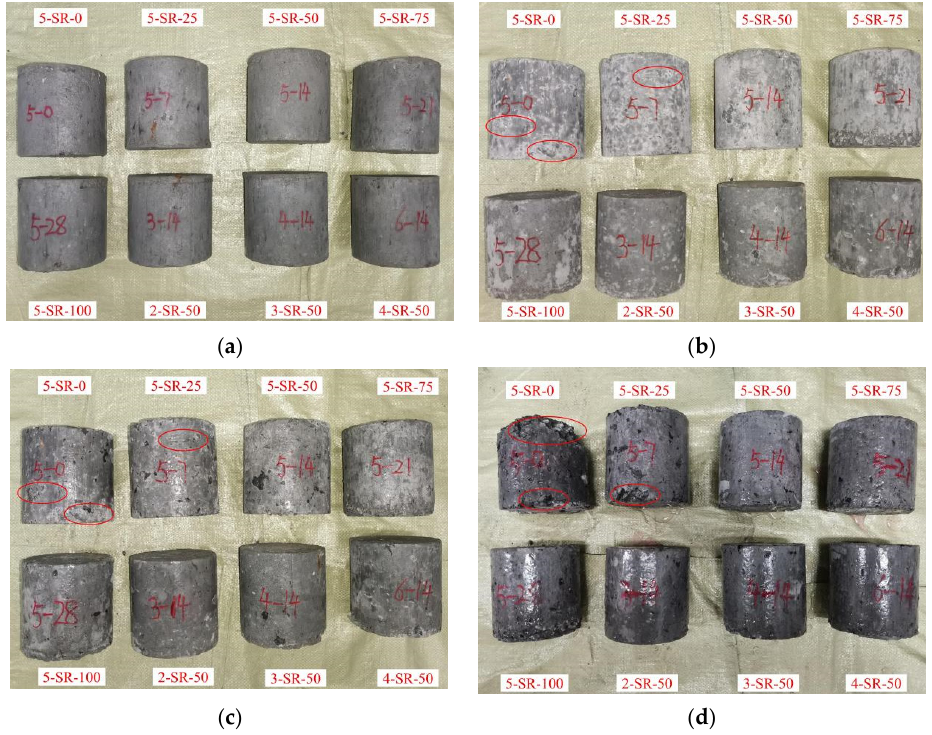
Figure 13. Changes in the appearance of specimens under different freeze–thaw cycles: ( a ) 0; ( b ) 5; ( c ) 15; and ( d ) 30 cycles.